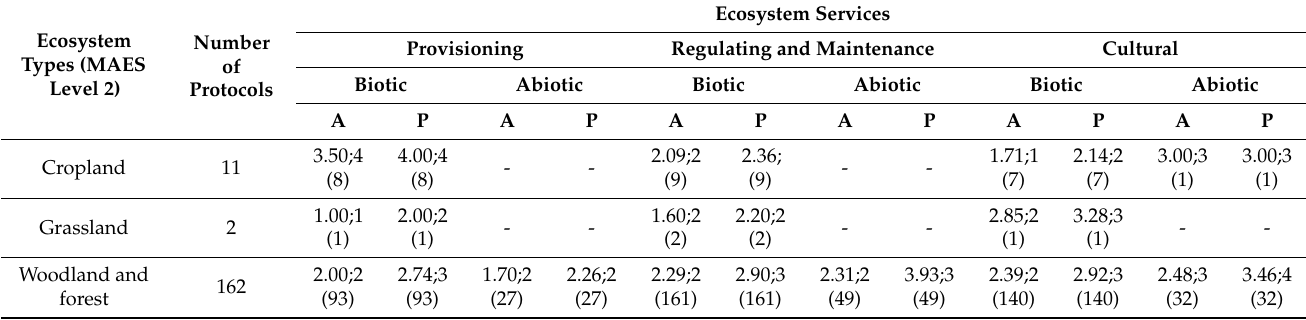
Table 7. Actual (A) and potential (P) supply for the main ecosystem services categories, per MAES level 2 ecosystem types. Each record depicts: mean rating; median of rates; (reference number of